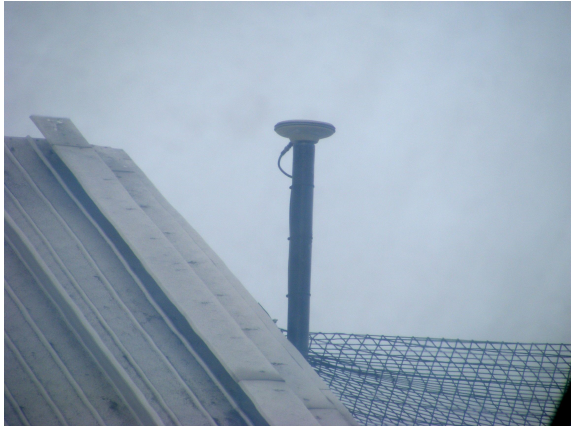
Figure 1: Antenna of the Leica SmartNet station UEL.